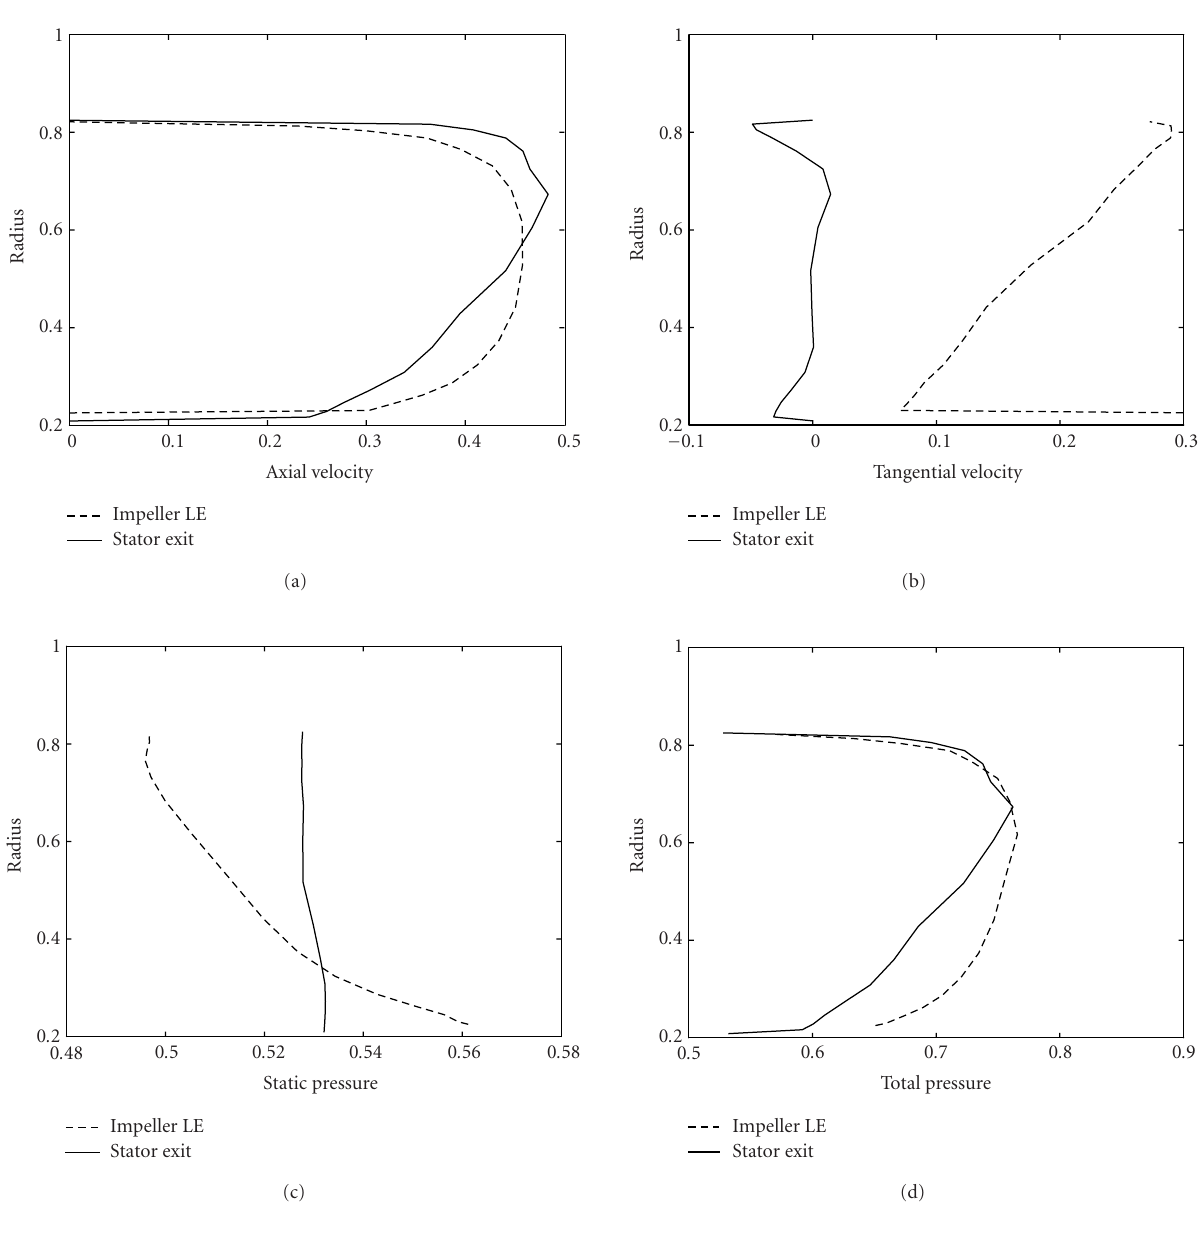
Figure 5: Comparison of stator and impeller